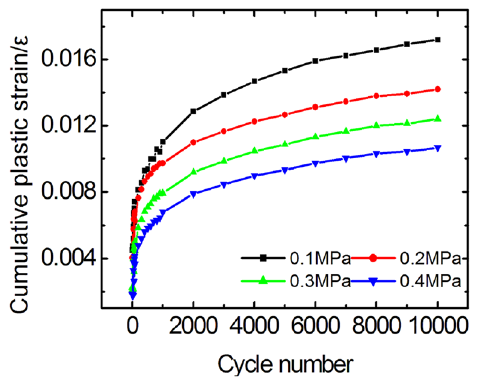
Fig. 12 Influence of the confining pressure on the cumulative plas- tic strain